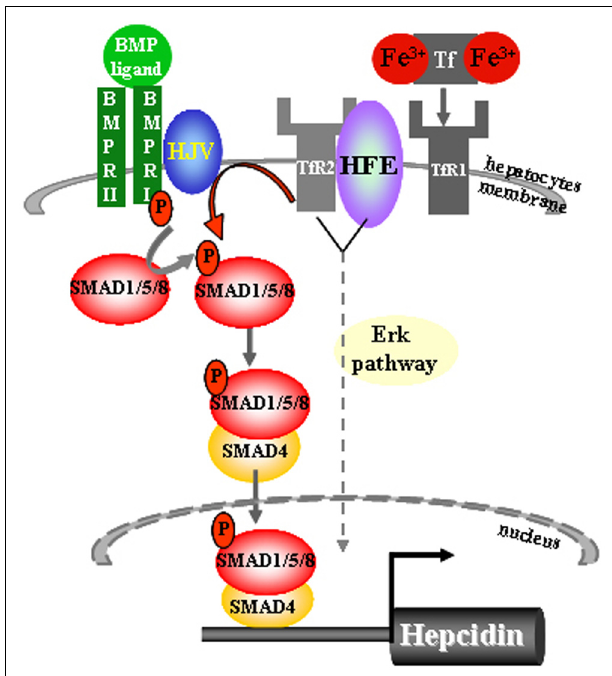
FIGURE 1 | Sensing of transferrin-bound iron and regulation of hepcidin expression in hepatocytes. The iron-sensing process involves binding of transferrin-bound iron toTfR1 causing a dissociation of Hfe from the Hfe/TfR1 partnership, relocation of Hfe toTfR2 and presumably the formation of a large membrane-bound complex composed of Hfe/TfR2/Hjv and BMPRII and I.This hepatocyte-membrane complex activates transduction cascade involving the phosphorylation of the Smad1/5/8 and subsequent binding of common Smad4 protein to form a transcriptional complex which directly activates hepcidin transcription.The Bmp/Smad signaling is the central pathway for the regulation of hepcidin transcription. Lack of Hfe and other components of the membrane-bound complex severely impair the phosphorylation of Smad1/5/8 and consequently the transcription of hepcidin. Combined deficiency of Hfe and TfR2 results in decreased Erk/Mapk signaling activity in the liver, implicating that additional or parallel signaling pathway to Bmp/Smad may be involved in the control of hepatic hepcidin